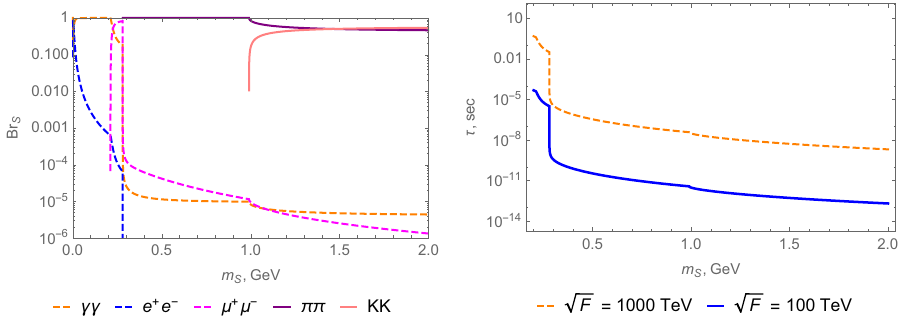
Figure 2. Branching ratios of a scalar sgoldstino (on the left panel). And Lifetime of a scalar sgoldstino as a function of its mass (on the right panel).